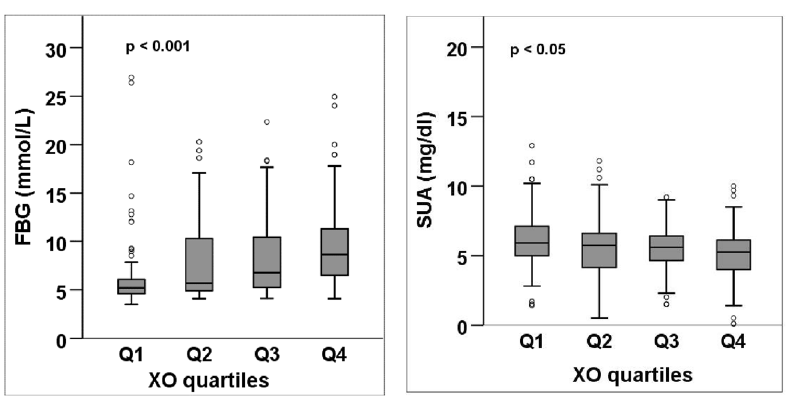
Figure 3. FBG and SUA levels across the XO quartiles. p-values are obtained from one-way